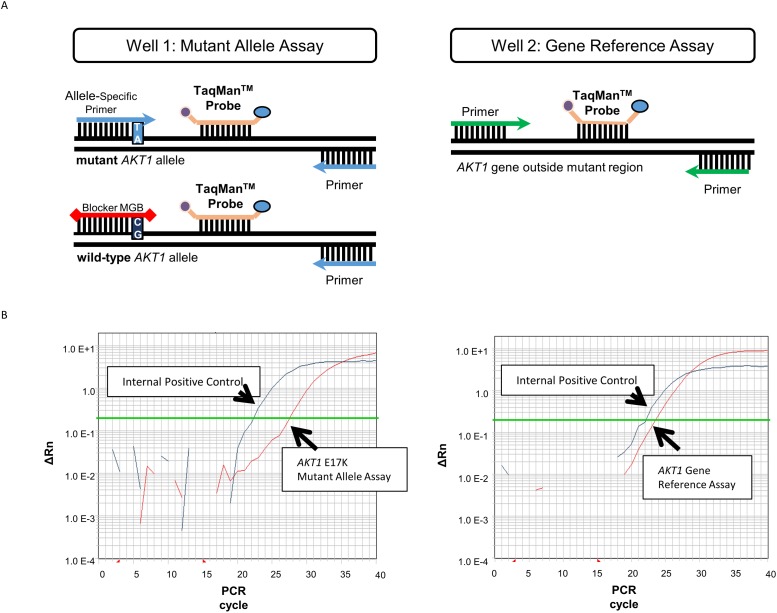
Schematic representation of the CastPCRTM assay.(A) Two independent amplification reactions are required for mutation detection: the Mutant Allele Assay, in which the mutant allele is amplified via the mutation-specific primer whilst amplification of the wild-type DNA is suppressed by the blocker containing the minor groove binder (MGB) (left), and the Gene Reference Assay, in which a DNA region located within the same gene but outside the mutant region is amplified (right). Both assays include an internal positive control (IPC) to control for PCR failure. (B) Example of Amplification Plots from a breast cancer sample analysis. The first curve to cross the signal threshold line (green line) represents the signal generated by the IPC reaction (blue line). The second curve (red line) represents the signal generated by the Mutant Allele Assay (left) or Gene Reference Assay (right). In this example, the Ct values for the Gene Reference Assay and the Mutant Allele Assay were 23.5 and 27.5 respectively. The resulting ΔCt is 4, indicating that the castPCR™ assay detected the AKT1 E17K mutation in this sample.